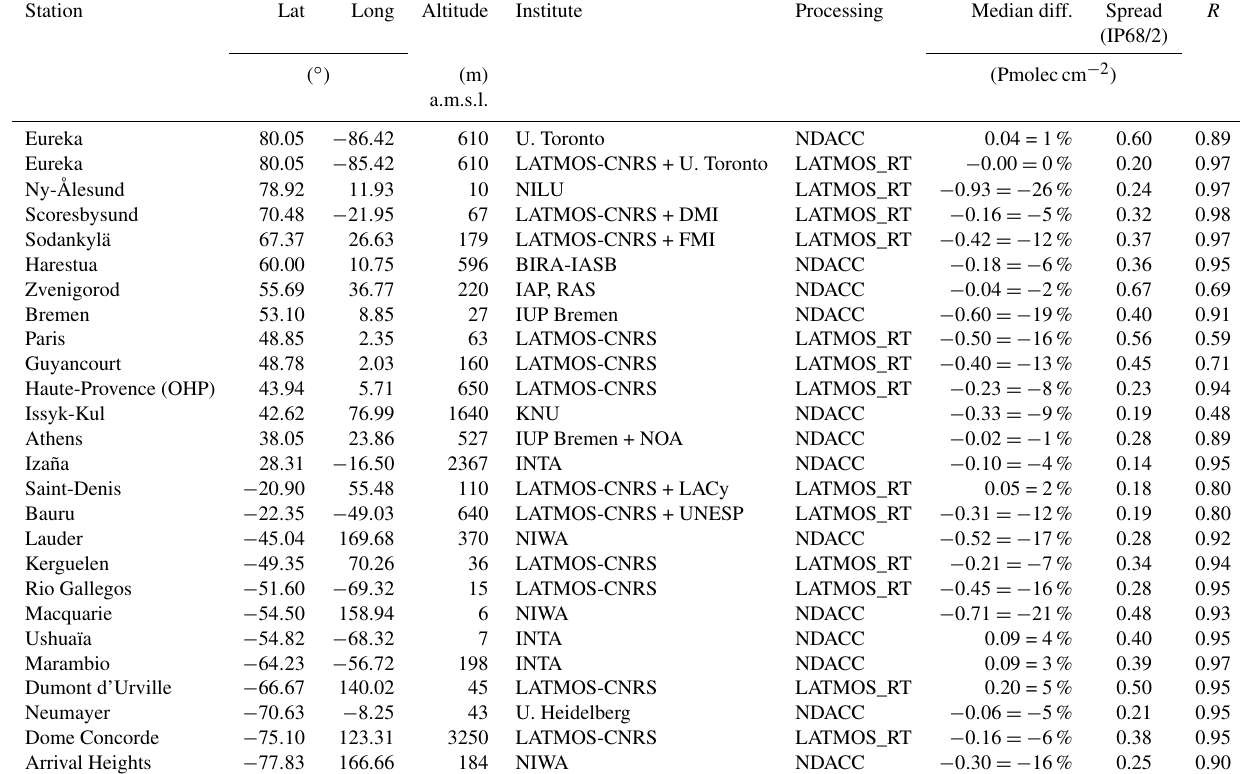
Table A1. ZSL-DOAS hosting stations, ordered by latitude, that contribute to the stratospheric NO 2 column validation. Several measures of the agreement between TROPOMI and the ground-based data are also provided. The bias over all stations (median over all station median differences) is − 0 . 23Pmoleccm − 2 , while the overall dispersion (median over all 1/2IP68) is 0.31Pmoleccm − 2 , and the inter-station dispersion (1/2IP68 over all station medians) is 0.30Pmoleccm − 2